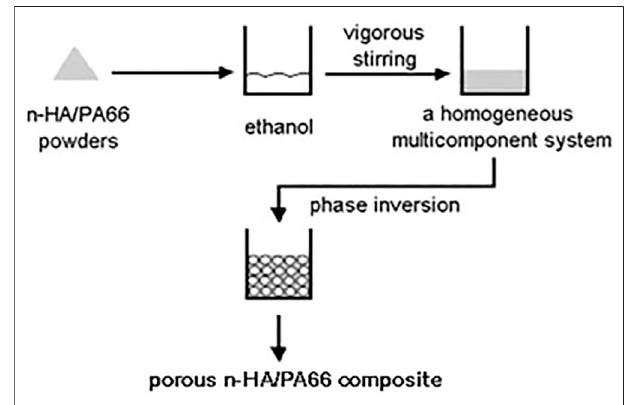
FIGURE 1 | Production method of the n-HA/PA porous scaffold